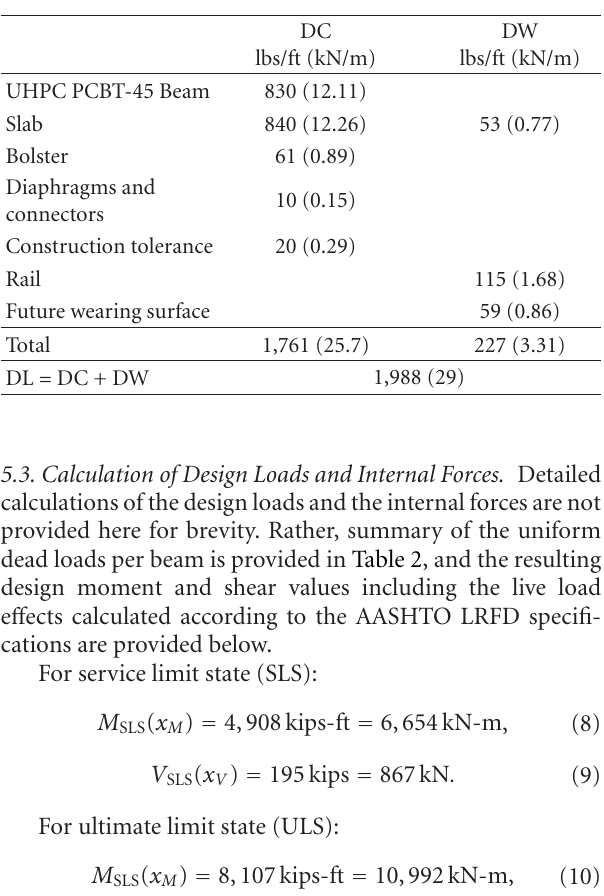
Table 2: Summary of uniform dead loads per